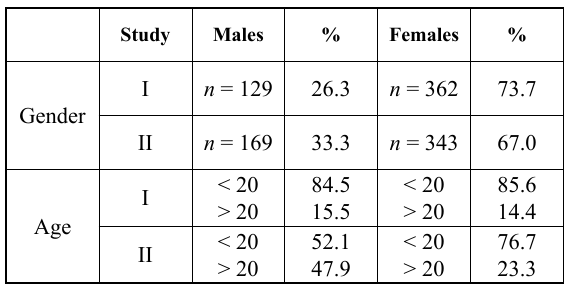
Table 1. Characteristics of